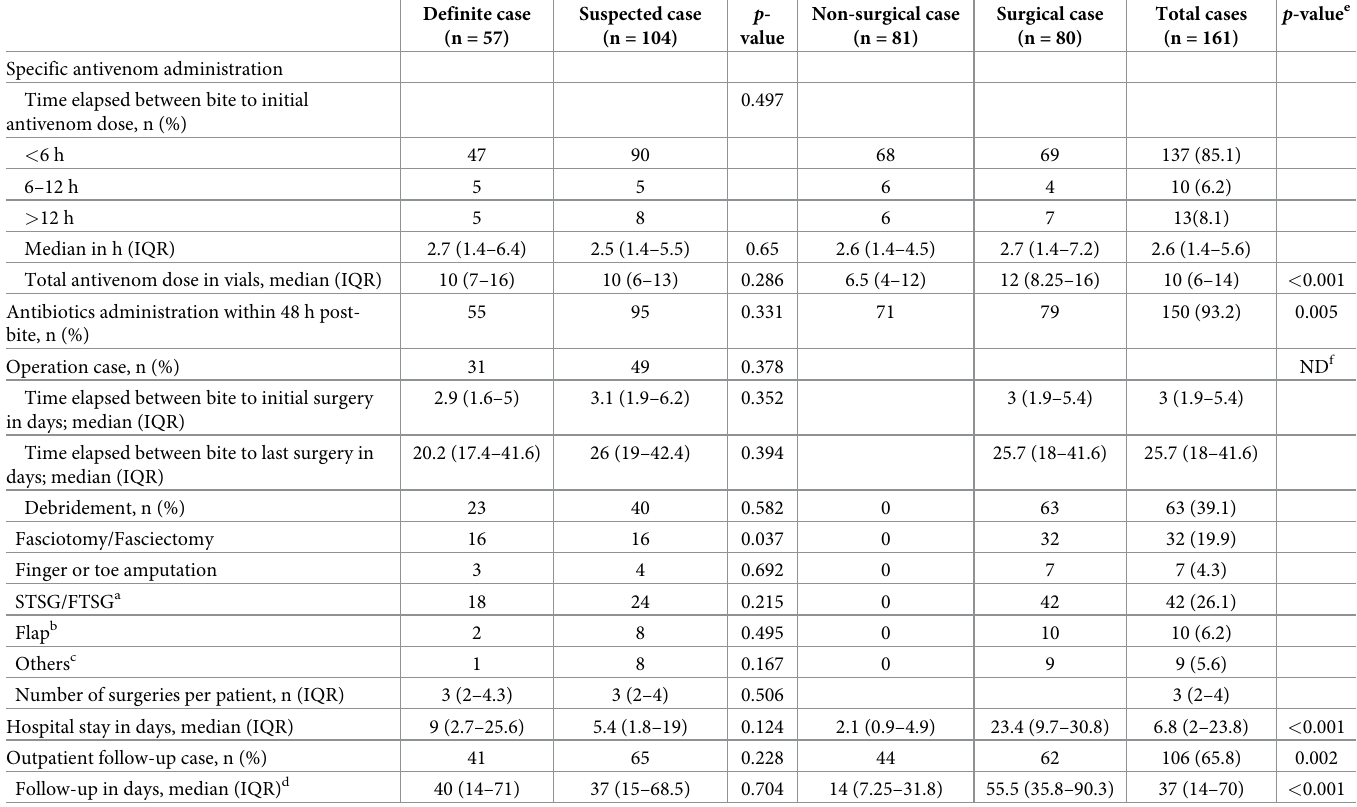
Table 3. Management of 161 Naja atra envenomed